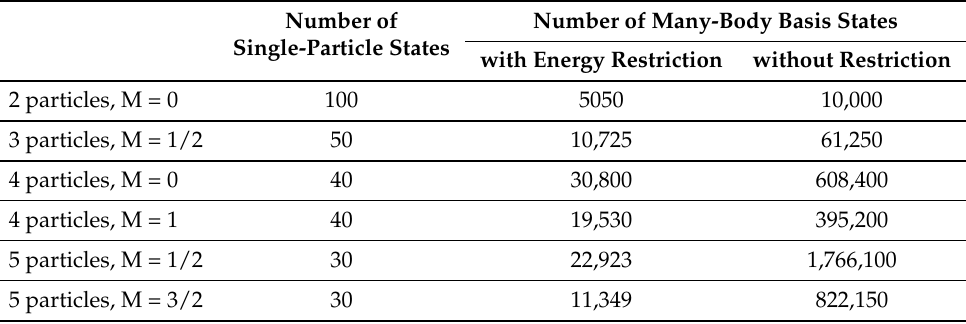
Table 1. Number of single-particle states used in the construction of the many-body basis states in the second column. The number of many-body basis states, with and without energy restriction, are shown in the third and fourth columns,